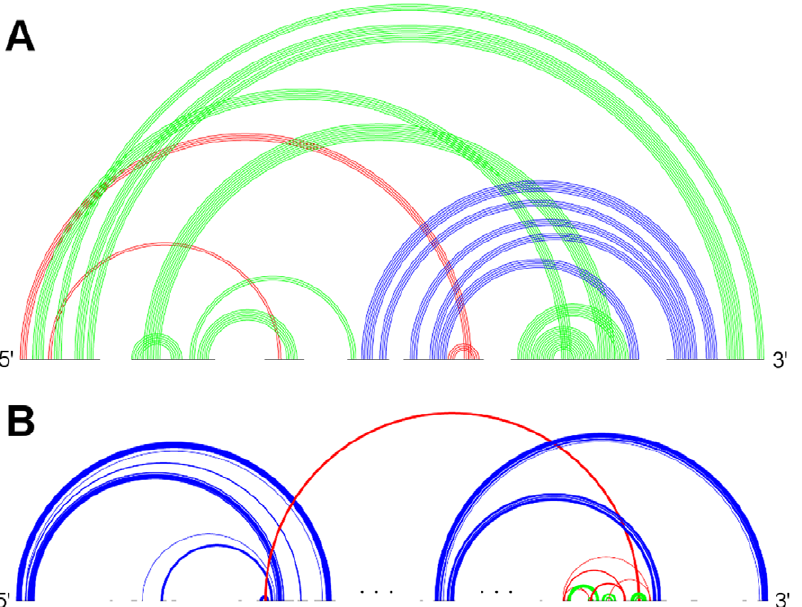
Figure 6. Typical sample structures for all genus 4 subclasses . A: RNA sequence CRW_00001 of subclass 4A with pseudoknot pattern ABCDEFEGCGHIAIJKBKFJHD. B: RNA sequence CRW_00521 of subclass 4B with pseudoknot pattern ABACDEFGHEGIHJKJFILBLDKC. (Stem color, blue: major stem; green: intermediate stem; red: minor stem).